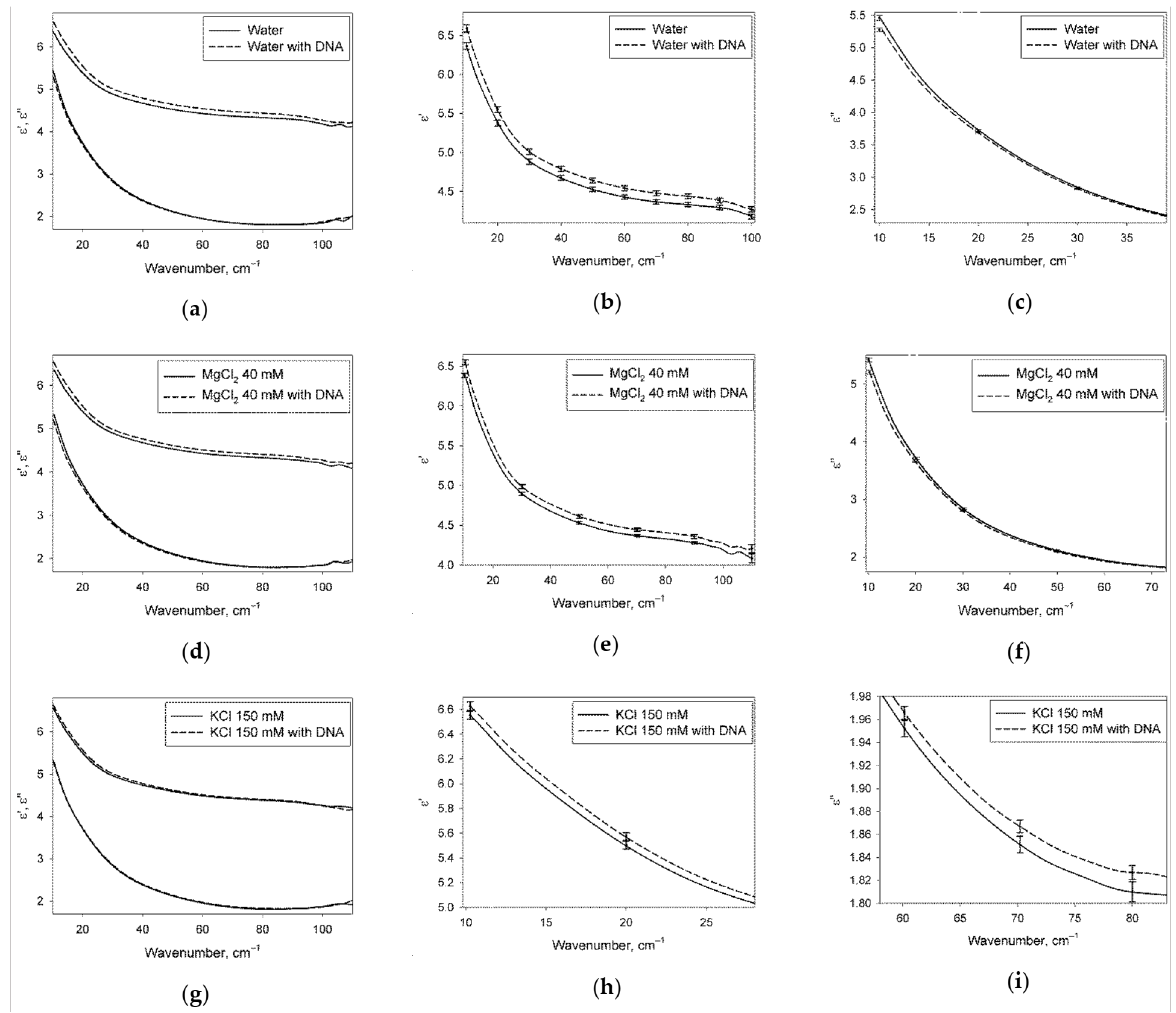
Figure 2. Pairwise comparison of DPs (real ε (cid:48) and imaginary ε (cid:48)(cid:48) parts) of the water phase of DNA solutions and aqueous DNA-free solutions with identical content of ions. The left part of the figure ( a , d , g ) shows DPs in the whole analyzed range of wavenumbers. The central and right parts of the figure ( b , c , e , f , h , i ) show ε (cid:48) and ε (cid:48)(cid:48) in the frequency regions where reliable differences were recorded. The error bars represent 95% confidence intervals. The original data are in Supplementary file S2.